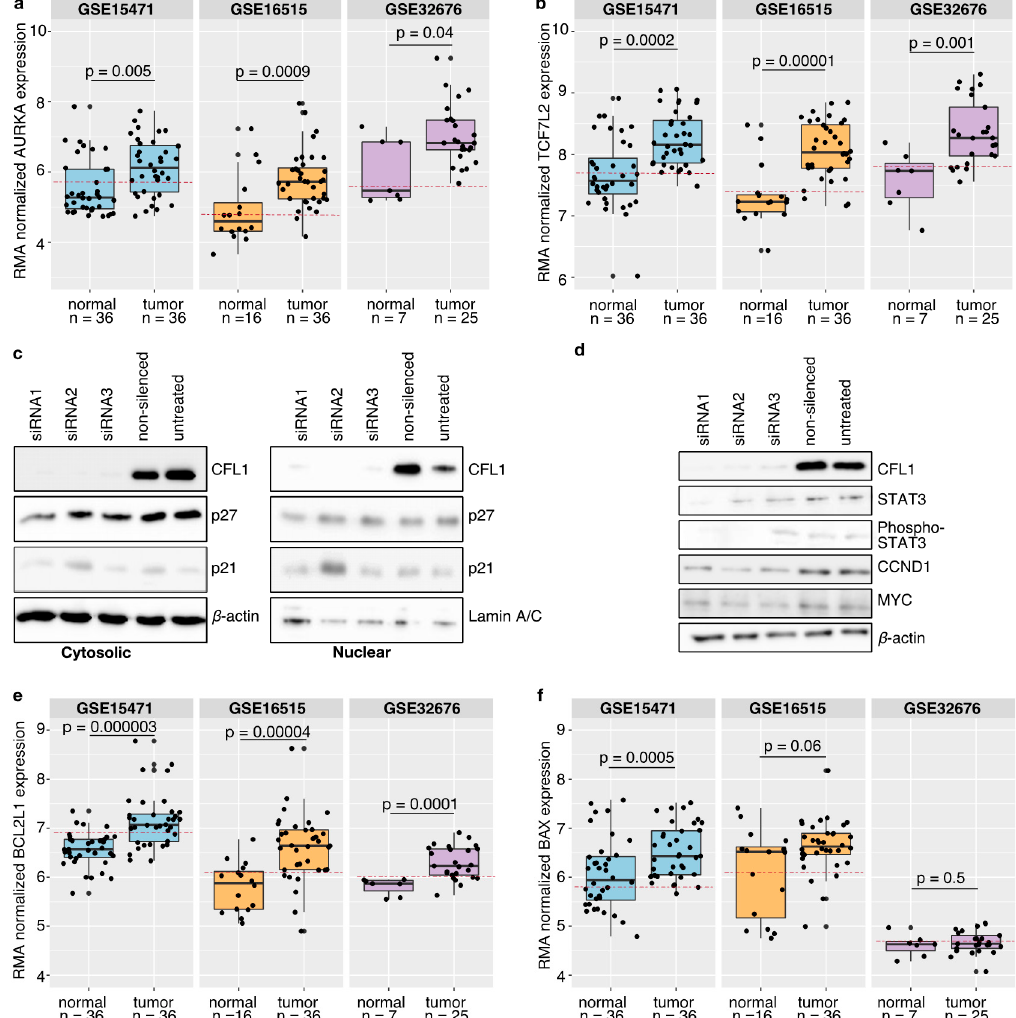
Figure 4. Model validation. ( a , b , e , f ) Three independent publicly available gene expression datasets (GSE15471, GSE16515, GSE32676) from healthy donors and pancreatic cancer tissues were compared with model suggestions. Statistical analyses were performed using the Wilcoxon test and p-values ≤ 0.05 were considered as significant. Only for the dataset GSE15471 containing matched tissues a paired Wilcoxon test was applied. Boxplots depict the median with the first and third quartiles. Binarization of the gene expression by a ROC curve revealed a threshold (red dashed line). Samples above that line